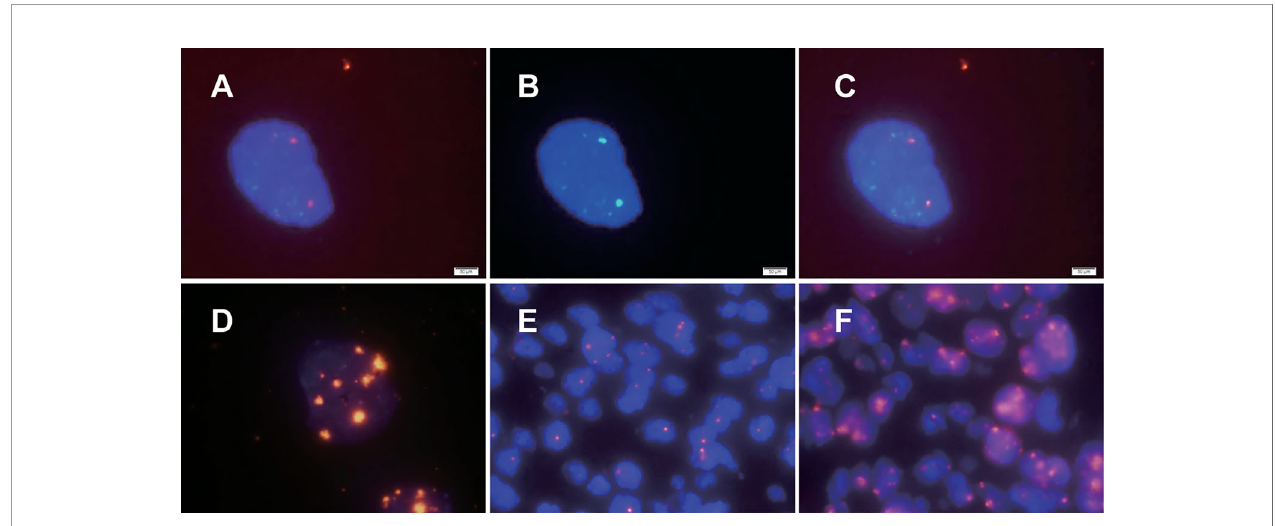
FIGURE 1 | HPV signal patterns in cervical cancer cell lines and cervical cancer paraf fi n sections detected by dual-color FISH. The fl uorescence intensity and area of the HPV signal were observed to increase with increasing HPV integrated copy number in cells, but the relationship was not linear. HPV signals in SiHa and CaSki cells are illustrated in (A, D) , respectively. (B) The speci fi c chromosomal site (Bacterial arti fi cial chromosome, BAC) probe targeting the 13q22 in SiHa. As shown in (C) , the HPV signal and the speci fi c chromosomal site probe targeting the 13q22 (RP11-315L12) signal were colocalized. There were two main types of HPV signals in paraf fi n specimens of cervical cancer: punctate signals and diffuse-punctate signals. The punctate signals indicate integrated HPV (E) , while diffuse signals indicate the presence of episomal HPV at the same time (F)